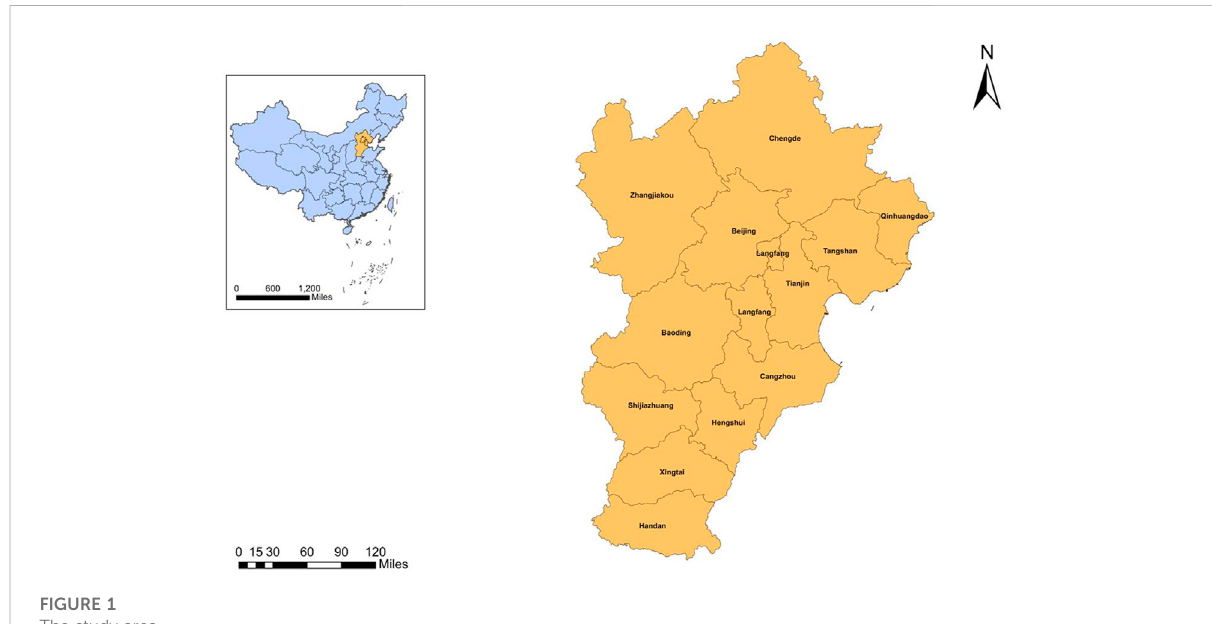
FIGURE 1 The study